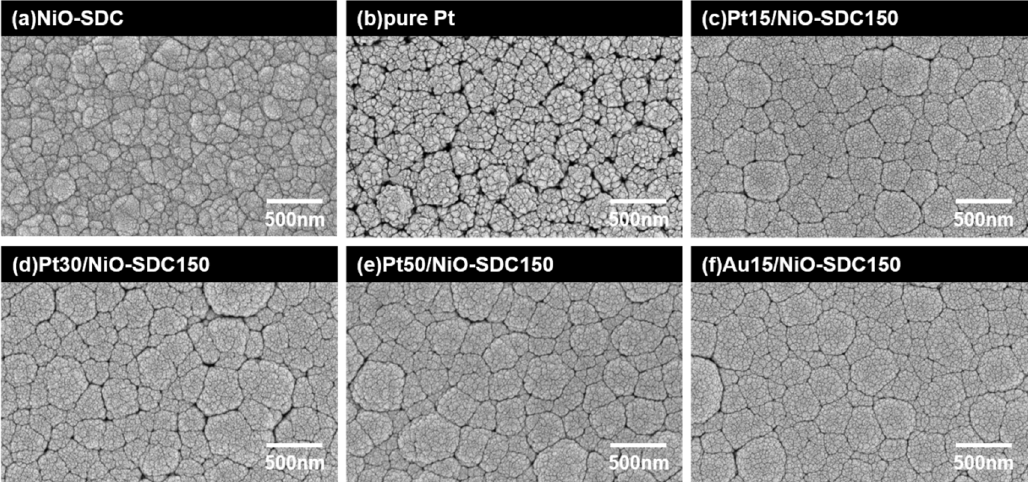
Figure 2. Surface morphologies of as deposited ( a ) NiO-SDC, ( b ) pure Pt, ( c ) Pt15 / NiO-SDC150, ( d ) Pt30 / NiO-SDC150, ( e ) Pt50 / NiO-SDC150, and ( f ) Au 15 / NiO-SDC150 on the AAO